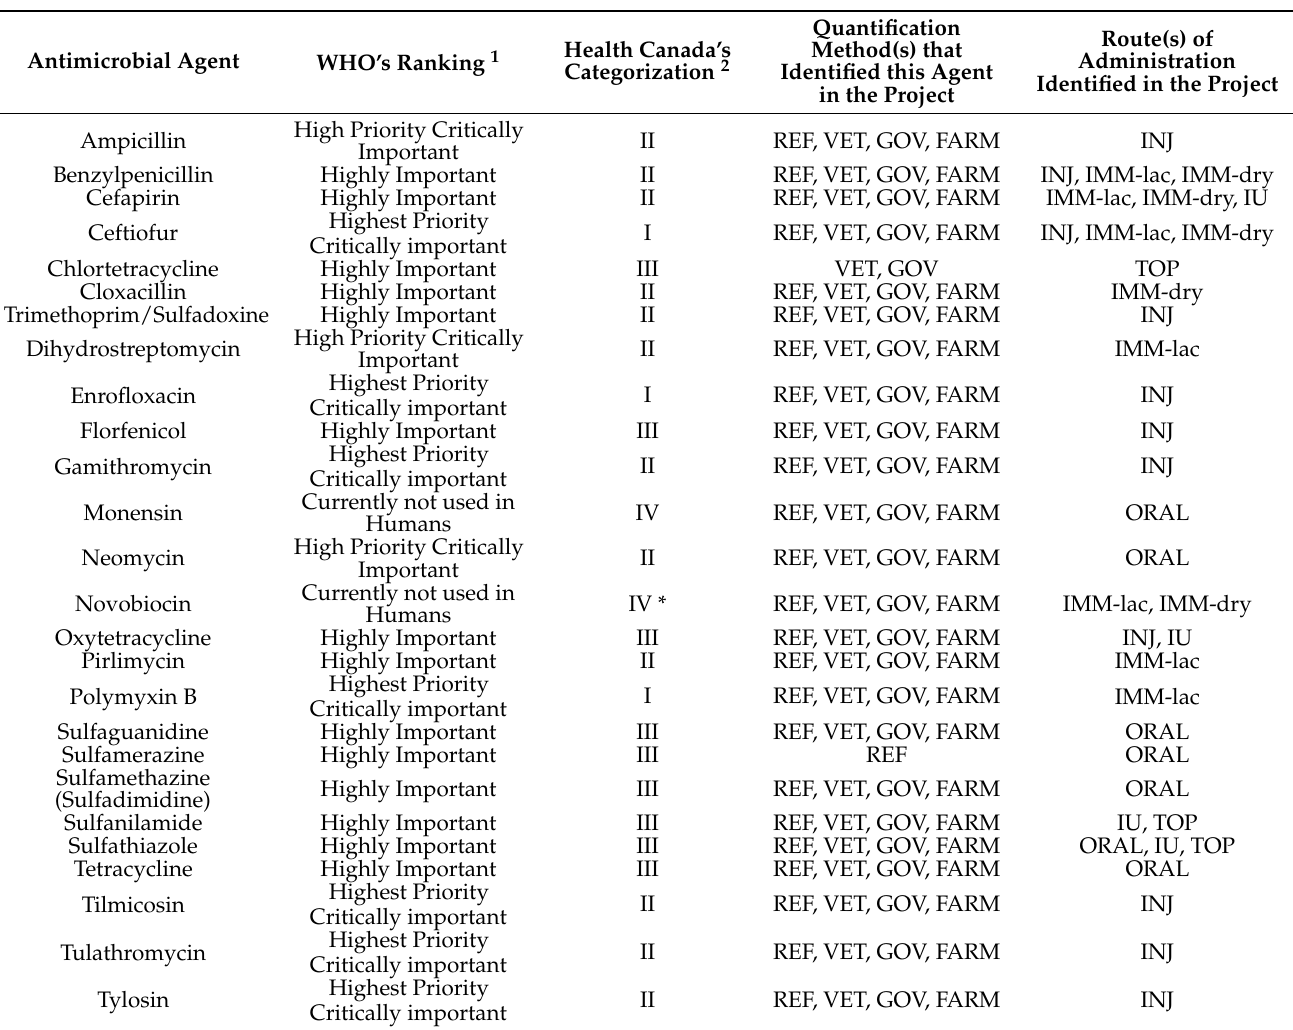
Table A2. Antimicrobial agents identified and quantified in Canadian Defined Course Doses for cattle (DCDbovCA) in the study, with their route(s) of administration (injectable, INJ; intramammary for lactating cows, IMM-lac; intramammary at dry-off, IMM-dry; oral other than in the feed, ORAL; intrauterine, IU; topical, TOP), and their category of importance in human medicine according to the World Health Organization (WHO) or to Health